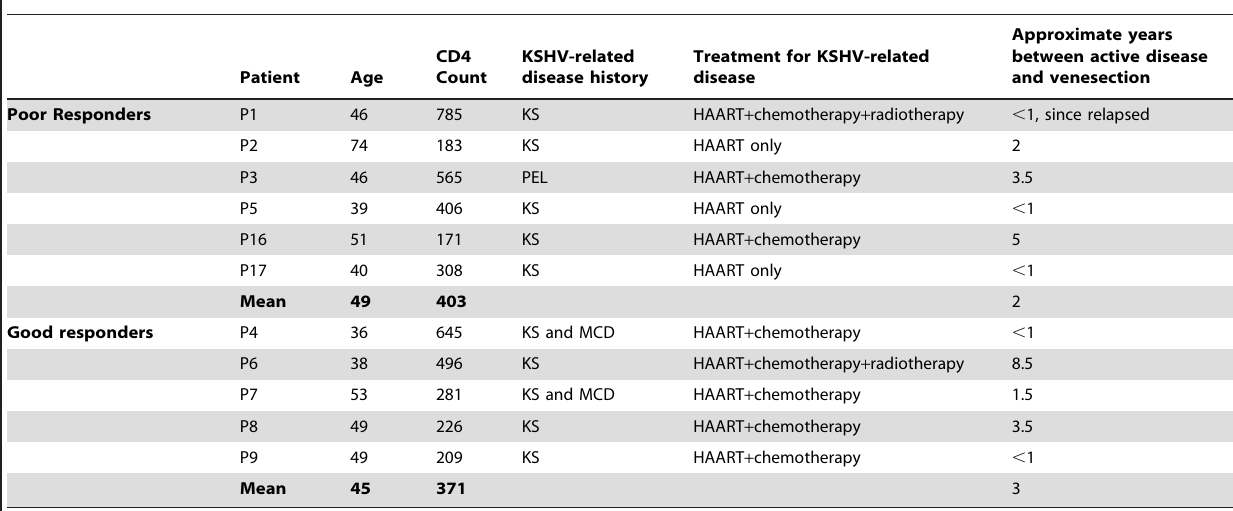
Table 2. Characteristics of HIV + individuals who are in remission from KSHV-related disease.